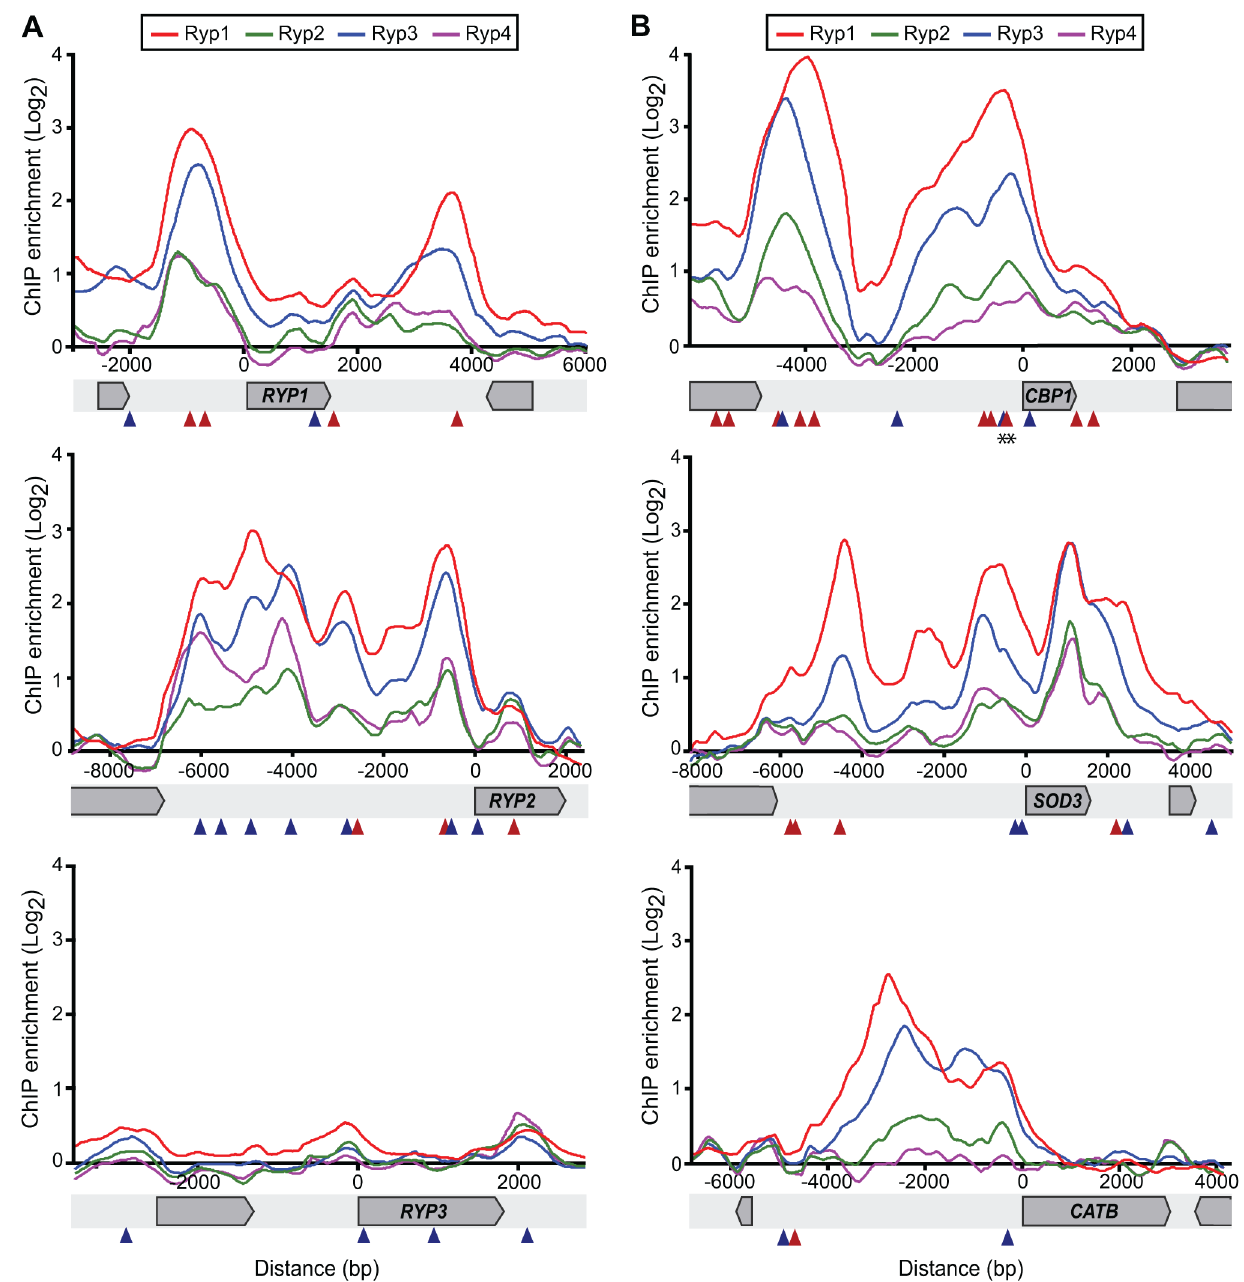
Figure 3. Ryp factors associate upstream of genes regulating morphology and virulence. ChIP-chip enrichment ratio versus genome coordinate for Ryp1, Ryp2, Ryp3, and Ryp4 ChIP events were plotted using Mochiview. Genome coordinates were adjusted to the start of the ORF of interest. Motif A (red triangles) and Motif B (blue triangles) locations shown in these loci were identified using MAST. Genomic regions of RYP genes (A) and virulence genes (B) are shown. Asterisks denote Motif A and Motif B probes used in the mobility shift assays in Figure 6C and